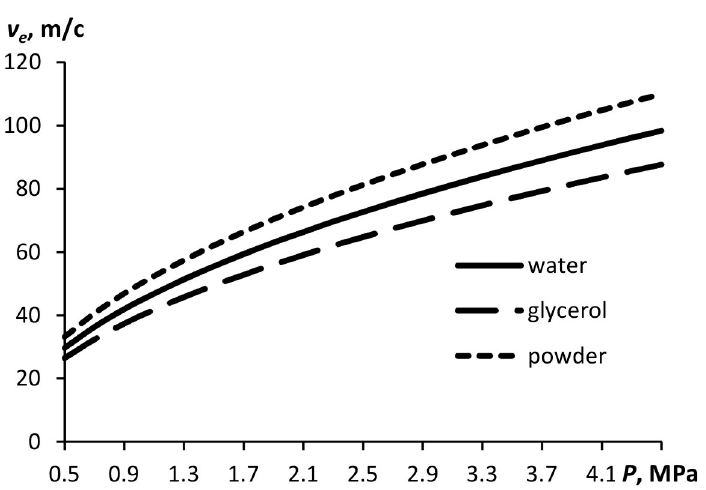
Figure 2. Outflow velocity as a function of pressure in the atomizer for substances with different densities ( ε = 0.3).